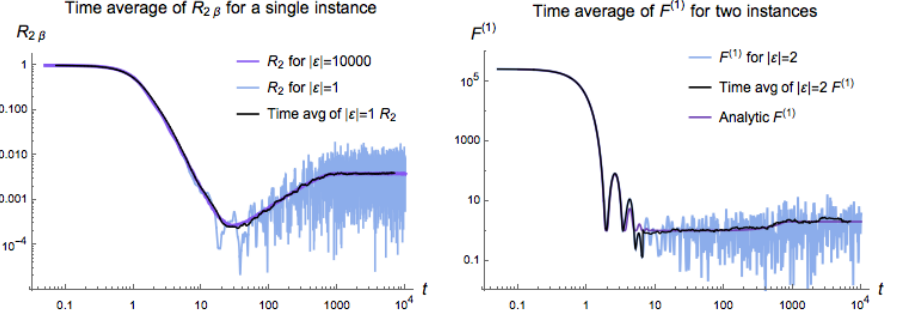
Figure 13 . Numerical computation of (cid:12)rst frame potential for the GUE at L = 32. On the left, we sequentially increase the number of samples and extrapolate to large sample size (red line), which agrees with the both the frame potential computed from R 2 numerics as in eq. (4.15) (blue line) and the analytic expression we derived for F (1) . On the right, we time bin average F (1) as described GUE GUE above and, for L = 32 and 100 samples, we (cid:12)nd good agreement with the quantities on the left.